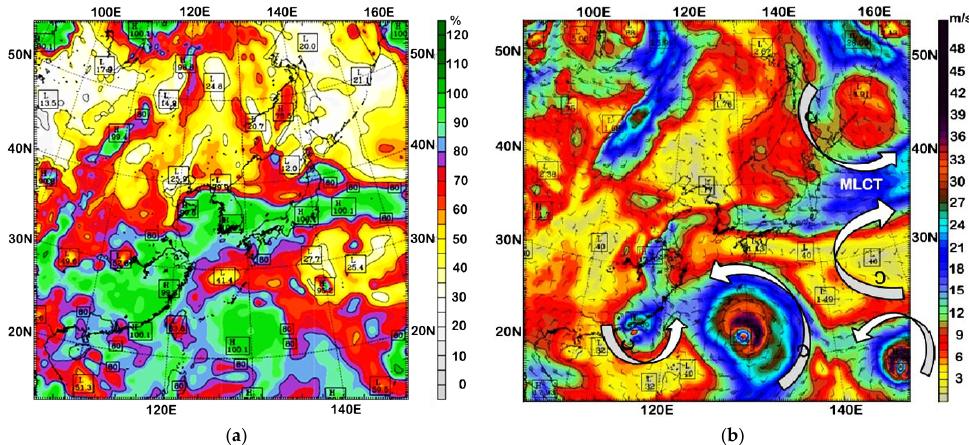
Figure 21. As shown in Figure 20, except for relative humidity ( a ) and ( b ) wind speed (m/s) 5 km height. The three typhoons became much closer to each other with stronger multiple interactions. Though STS Linfa made landfall at Lufeng city and moved westward instead of weakening, it strengthened by mutual feedback of moisture and momentum fluxes with the more intensified TY Chan ‐ Hom better than at 1.5 km height.